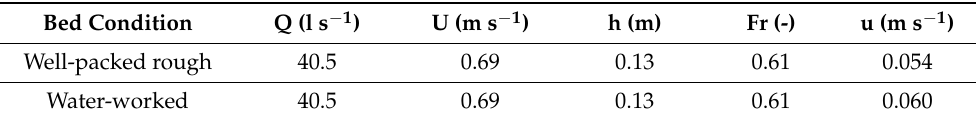
Table 1. Basic experimental conditions for flow